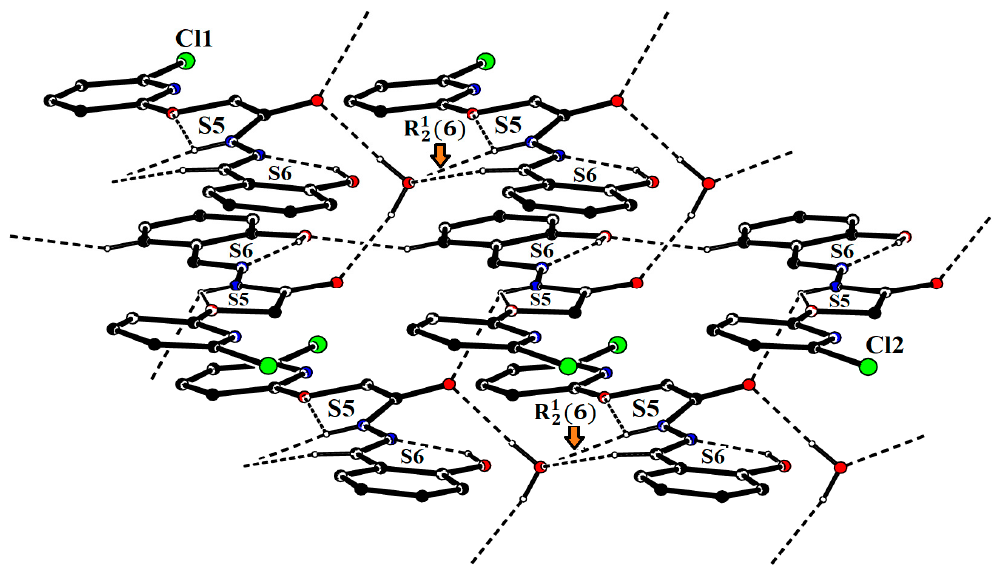
Figure 4. Packing diagram of HBPAH showing H-bonded connection of first, 2nd type of molecules and water with H-atoms not engaged in H-bonding are omitted for clearness. Red color shows oxygens, blue nitrogen, green chlorine, and black/white contours shows carbon atoms. Table 2. Geometrical parameters of potential Hydrogen-bonds (Å, º) for HBPAH.